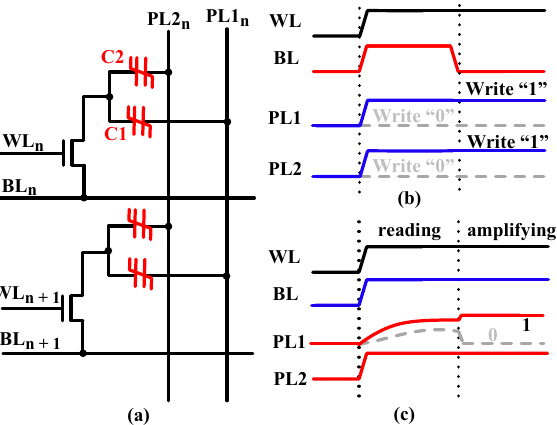
Figure 5. ( a ) A 2 × 1 array of the 1T2C cell. ( b ) Write timing. ( c ) Read timing. During writing, the same voltage pulse is applied to the plate lines, PL1 and PL2, to polarize the two FeCAPs to the same state. During reading the 1T1C FeCAP cell, PL is applied with a reading pulse, and BL is left floating [28,29]. Then, BL is charged by the polarized charge in the FeCAP. Finally, the BL voltage is compared with the reference voltage using SA to read out the stored data. For 1T2C, when the FeCAP C1 is read, the polarization state of the C2 will be affected by the BL voltage. Hence, during the reading process of 1T2C, BL and PL2 are applied with the same read pulse, and PL1 is left floating. Then, PL1 is charged by the polarized charge in the FeCAP, that is, C1. Finally, the PL1 voltage is compared with the reference voltage using SA to read out the stored data. The 1T2C-type FeCAP has only little effect on the area of the memory cell because the area of the transistor determines the cell area. The area of the transistor is substantially much larger than that of the FeCAP, as shown in Figure 6.